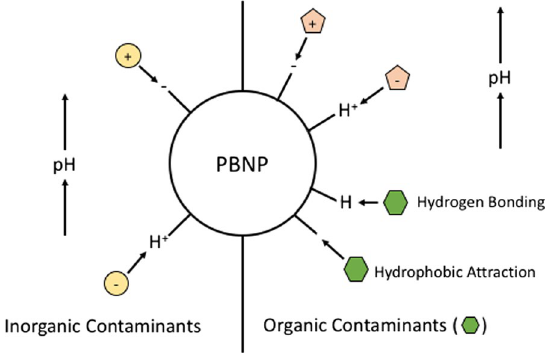
Fig. 1 Schematic diagram of the surface of PBNPs as a function of increasing solution pH, demonstrating mechanisms of contaminant adsorption